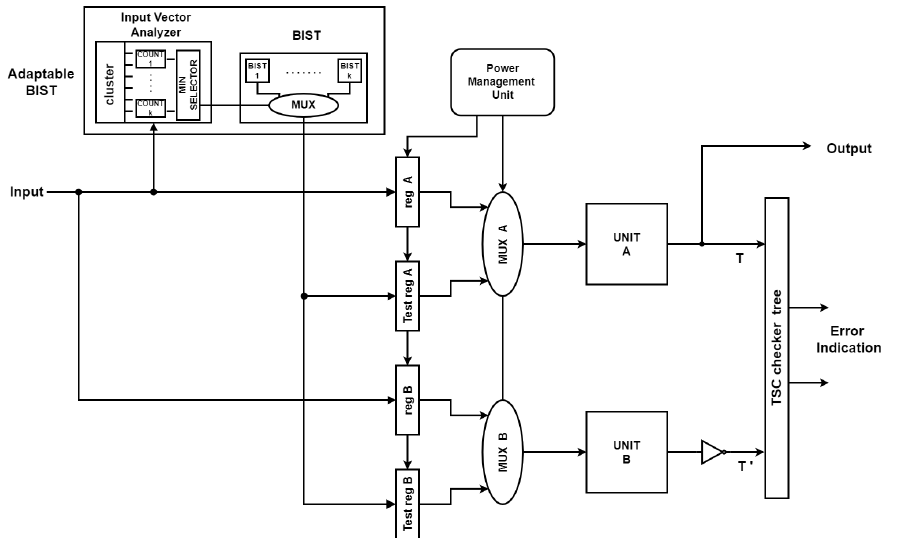
Figure 8. Dynamic selection of test vectors set to confront the degrading effect due to late appearance of the appropriate test